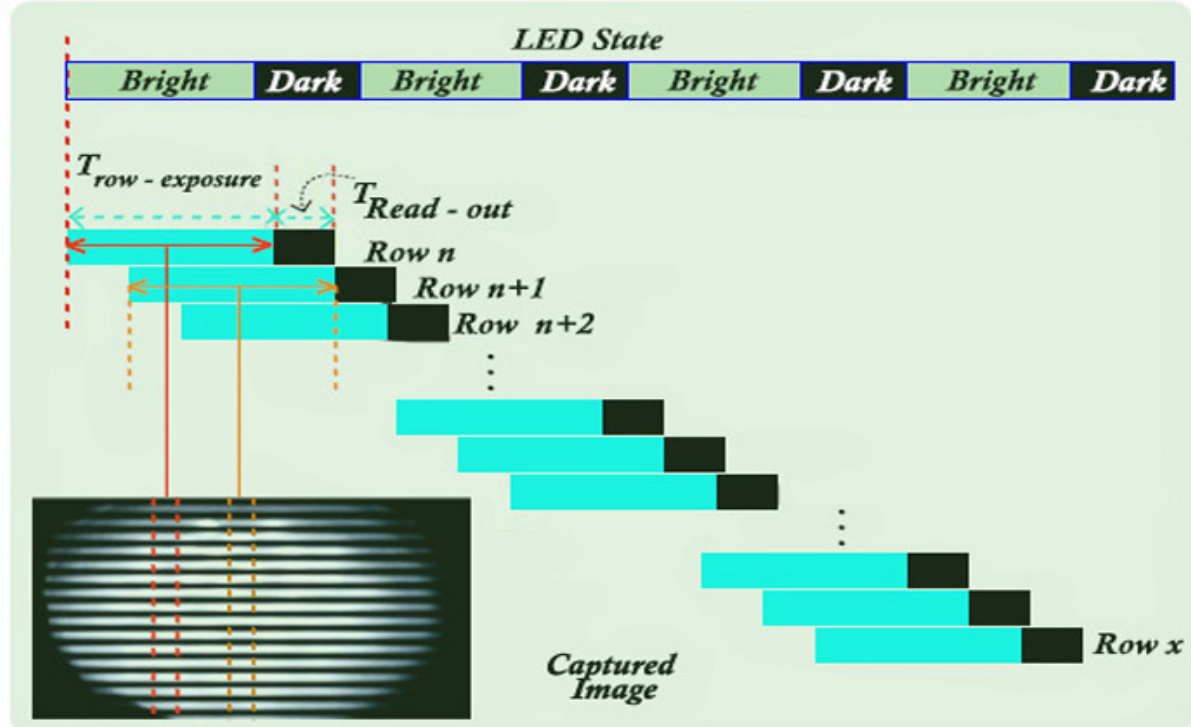
Figure 4. Diagram showing the technique of extracting information from an LED using optical communications based on the smartphone’s camera.